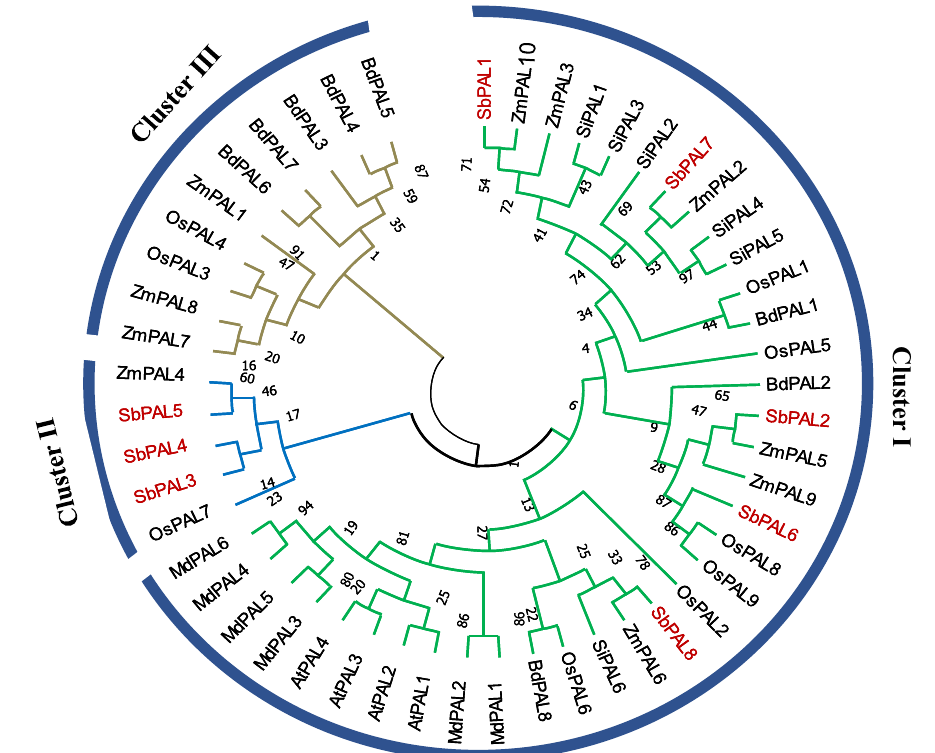
Figure 2. Phylogenetic analysis of the phenylalanine ammonia-lyase (PAL) genes in sorghum ( SbPAL ), rice ( OsPAL ), maize ( ZmPAL ), Brachypodium ( BdPAL ), barley (Horvu), and Arabidopsis